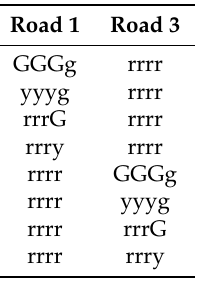
Table 1. Traffic signal